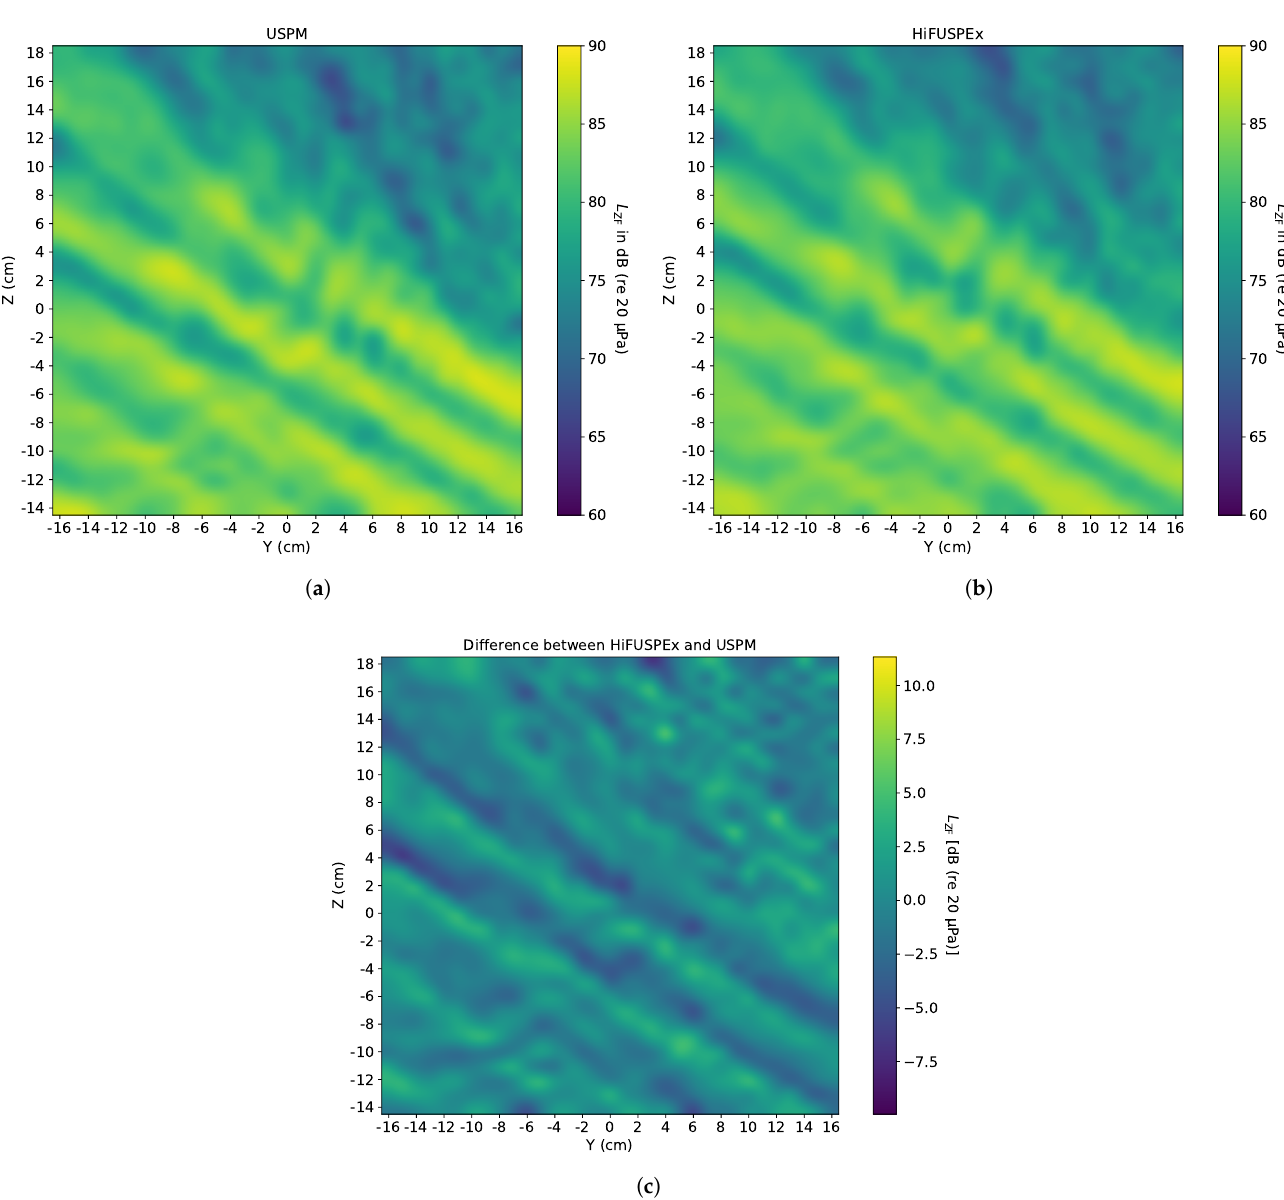
Figure 14. Sound fields within the scanning unit when an idealized signal of a welding machine (10 kHz + 20 kHz) was simulated. Results were obtained on the right-hand side with the artificial head in the standing position and with the protection grid mounted. The presented plots show the sound fields obtained for: ( a ) USPM; ( b ) HiFUSPEx; and ( c ) difference between the HiFUSPEx and the USPM. Please refer to Figure 10 for identification of zy